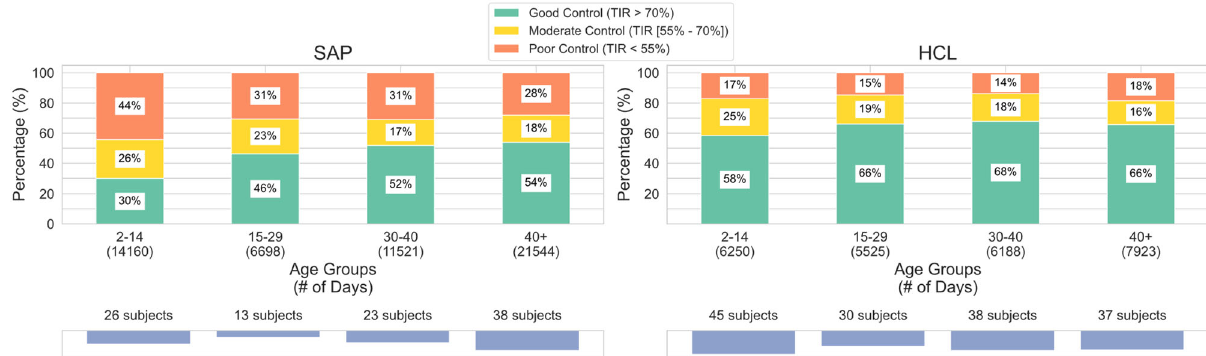
Fig. 5 Glycemic control by age group. Glycemic control improved with age in the SAP population and was worse in the youngest group of subjects between the ages 2 – 14 across both the SAP and HCL populations.